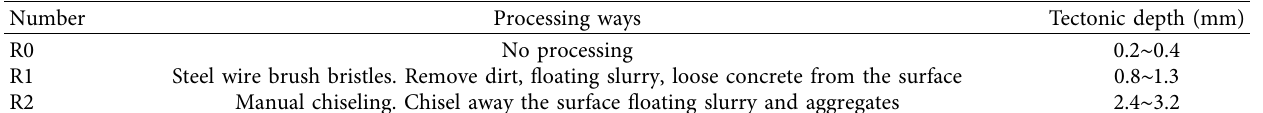
Table 9: Bonding interface preparation.